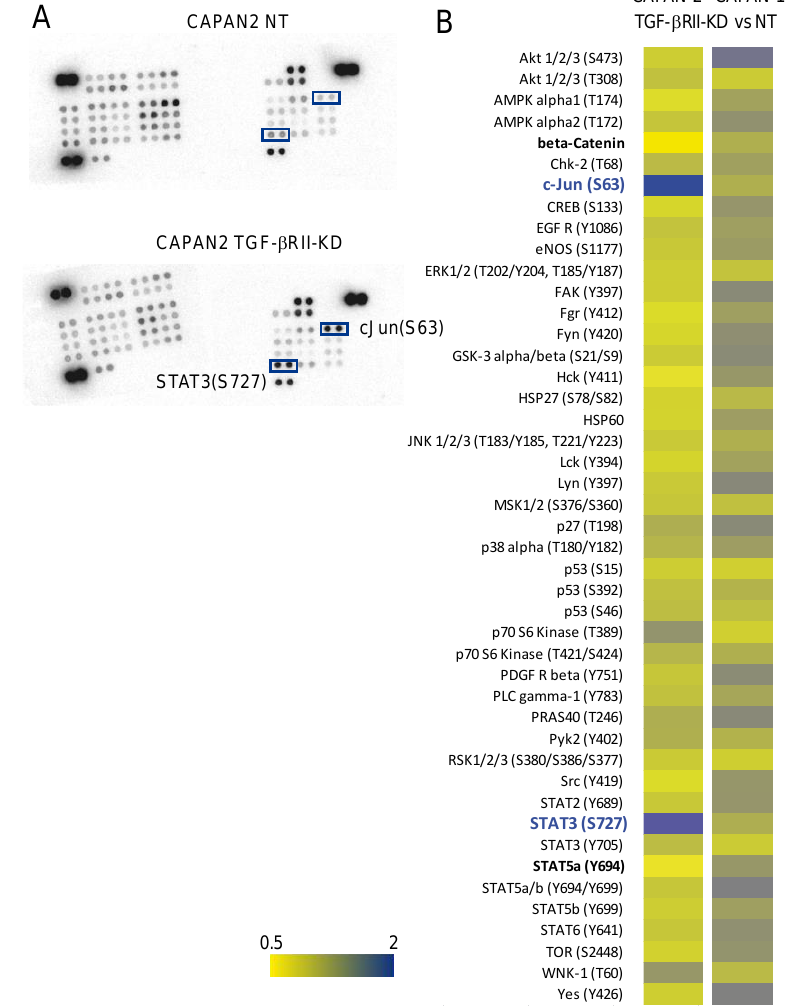
Figure 4. Impact of TGF- β RII knocking-down on signaling pathways. ( A ) Impact of TGF- β RII knocking-down on intracellular signaling was studied using phospho-arrays that detect relative site-specific phosphorylation of 43 proteins. Boxes highlight spots for S63 c-Jun and S727 STAT3. ( B ) Heatmap representing the intensities of each spot (TGF- β RII vs. NT) that were measured and normalized to the reference spots for CAPAN-1 and CAPAN-2